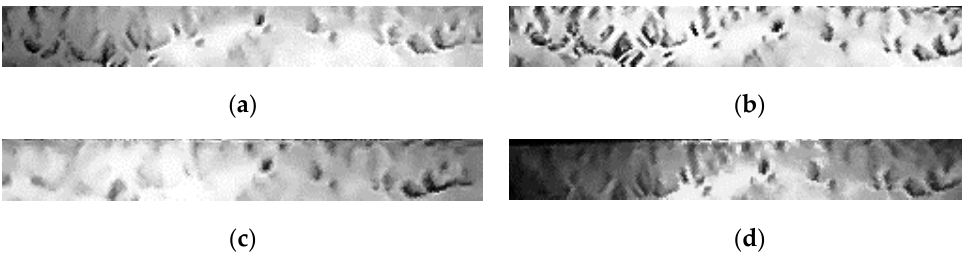
Figure 4. Steady change of constrained iris texture taken of the same person.